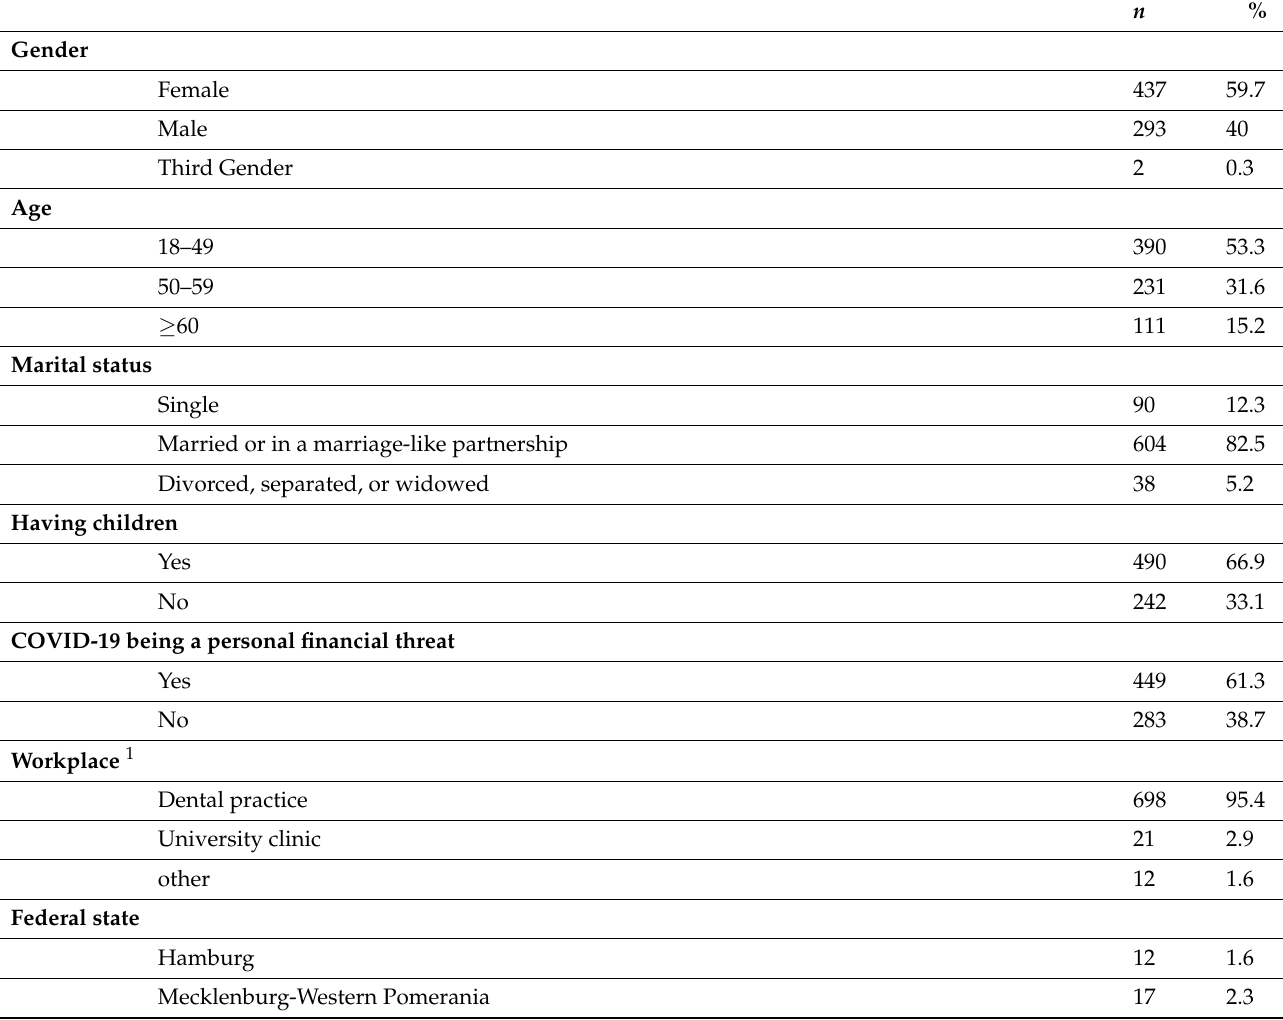
Table 1. Characteristics of Participants ( n =